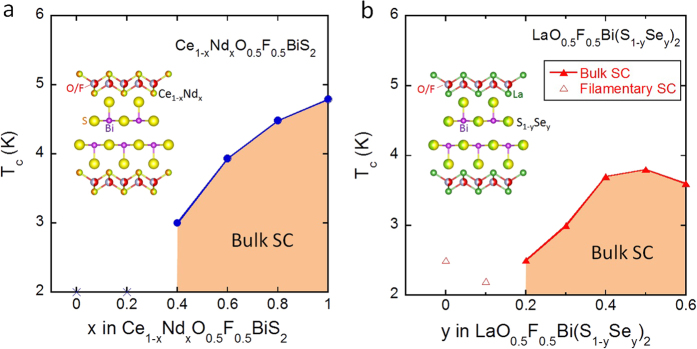
Superconductivity phase diagrams of Ce1−xNdxO0.5F0.5BiS2 and LaO0.5F0.5Bi(S1−ySey)2.(a) Superconductivity phase diagrams of Ce1−xNdxO0.5F0.5BiS2. For x = 0 and 0.2, superconducting transition is not observed at T > 2 K. For 0.4 ≤ x ≤ 1, superconducting transition with a large shielding signal, with which we could regard the samples as a bulk superconductor (Bulk SC), is observed. Tc increases with increasing x. The inset figure shows a schematic of crystal structure of Ce1−xNdxO0.5F0.5BiS2. (b) Superconductivity phase diagrams of LaO0.5F0.5Bi(S1−ySey)2. For y = 0 and 0.1, superconducting transition is observed but their shielding signals are very small as a bulk superconductor (Filamentary SC). For y ≥ 0.2, superconducting transition with a large shielding signal is observed (Bulk SC). Tc increases with increasing y up to y = 0.5. The inset figure shows a schematic image of crystal structure of LaO0.5F0.5Bi(S1−ySey)2.